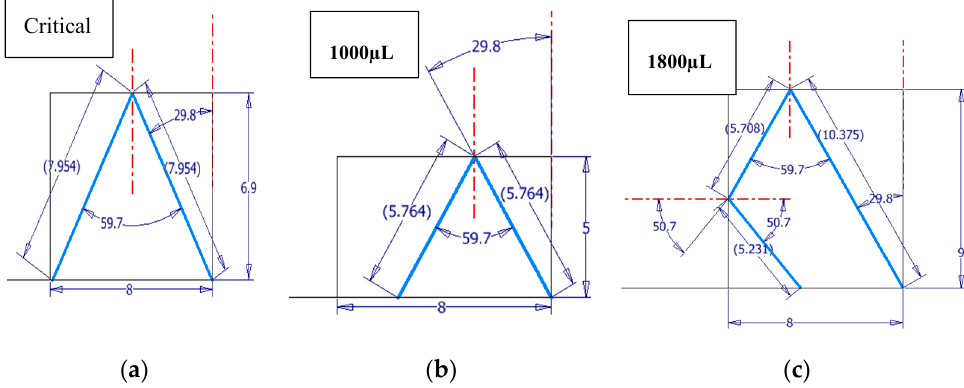
Figure 7. The CAD results for the wave traveling in the liquid, showing the actual total traveled distance for three cases: the ( a ) critical case; ( b ) 1000 μ L case, and ( c ) 1800 μ L